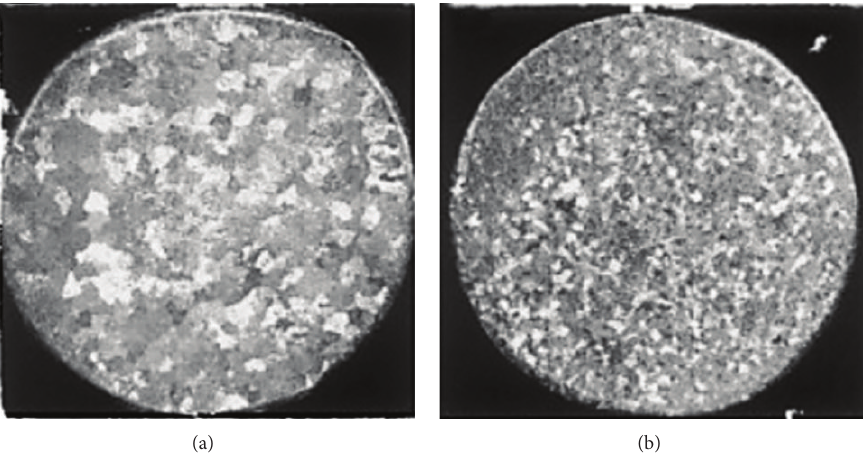
Figure 11: Microstructures of macroetched test samples of commercial purity Al: (a) unrefined; (b) refined by Al-5Ti-1B master alloy [39].